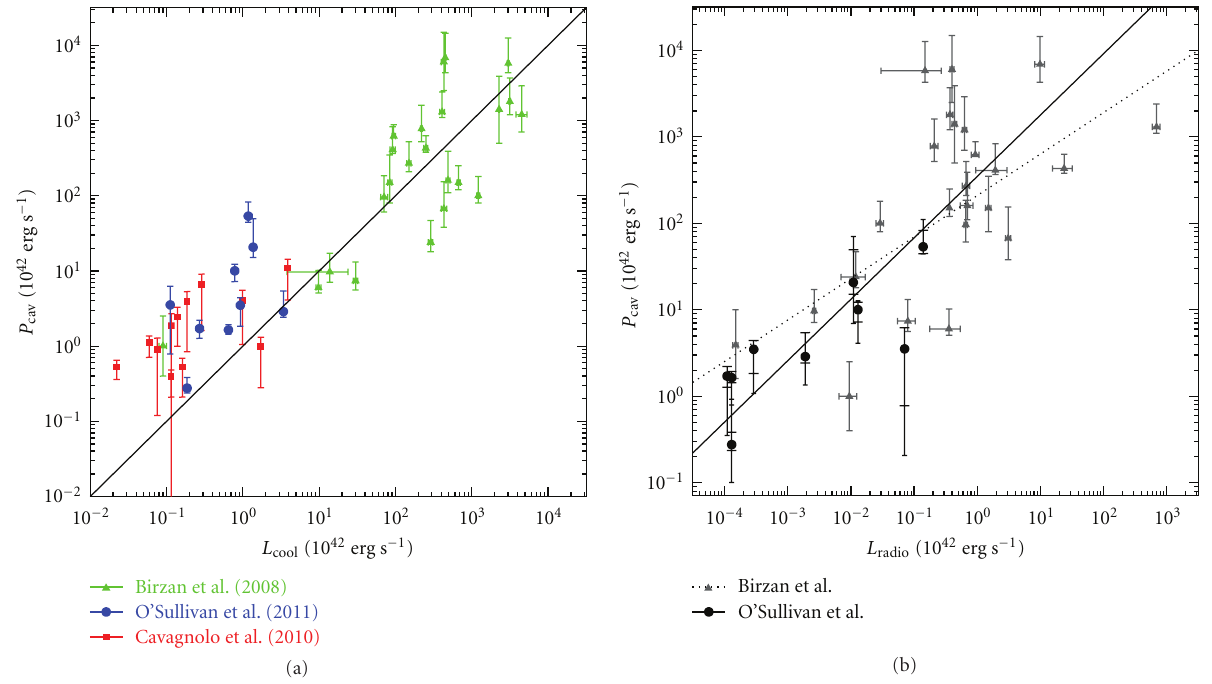
Figure 2: (a) Cavity power of the central AGN, P cav , versus the X-ray luminosity of the ICM inside the cooling region, L cool . The cavity power is calculated assuming 4 pV of energy per cavity and the buoyancy timescale. Di ff erent symbols denote systems in di ff erent samples presented in the literature: green triangles : Bˆırzan et al. [8], red squares : Cavagnolo et al. [169], blue circles : O’Sullivan et al. [165]. 1 σ uncertainties on cavity power are indicated by error bars (see [165] for details). The diagonal line denotes P cav = L cool . Credit O’Sullivan (private communication). (b) Cavity power of the central AGN, P cav , versus integrated 10MHz–10 GHz radio power, L radio , for the systems in the sample of Bˆırzan et al. (grey triangles) and the groups in the sample of O’Sullivan et al. (black circles). The solid fit line indicates the regression fit to the data points calculated by O’Sullivan et al. [165]. The dotted line indicates the relation found by Bˆırzan et al. [8]. Adapted from O’Sullivan et al.